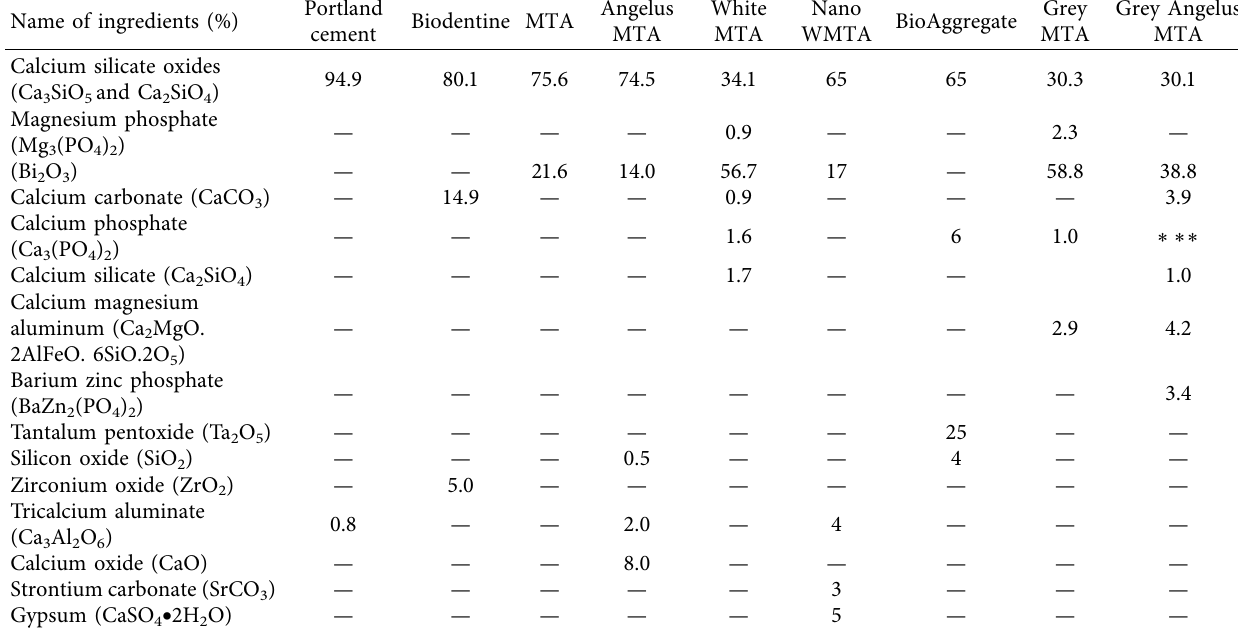
Table 1: Calcium silicate-based cements used in endodontics